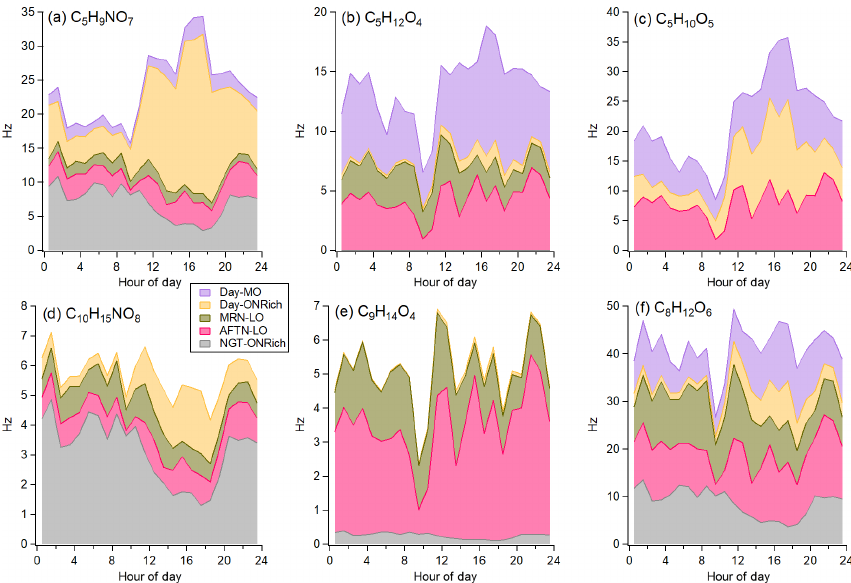
(cid:113) , iso- (cid:113) , non-IEPOX pathway);